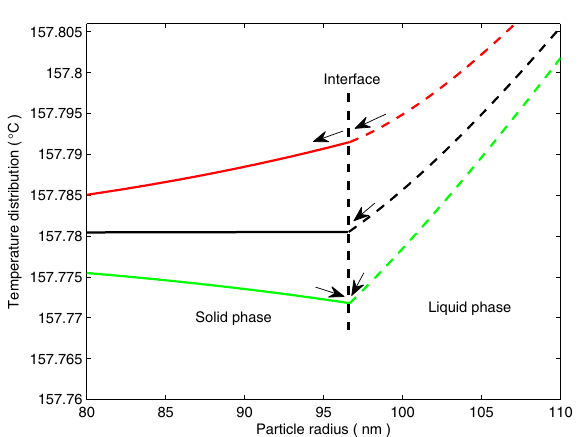
Figure 3. Size dependence of the melting temperature profile for Al nanoparticles. The black circles are the experimental data of a self-assembled Al nanoparticles made by Lai et al. 8 . The red and green lines represent the melting temperatures along the <010> and <111> crystal orientations, plotted with the asymptotic solution (17) considering the anisotropy of surface energy.